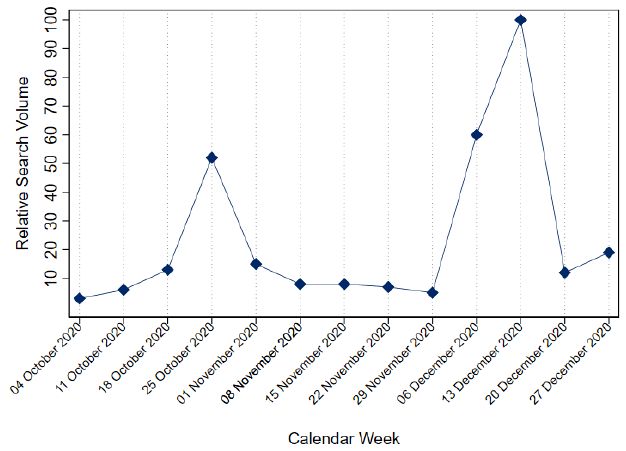
Figure 2. Relative Google-search volume for “Lockdown” in Germany by week.